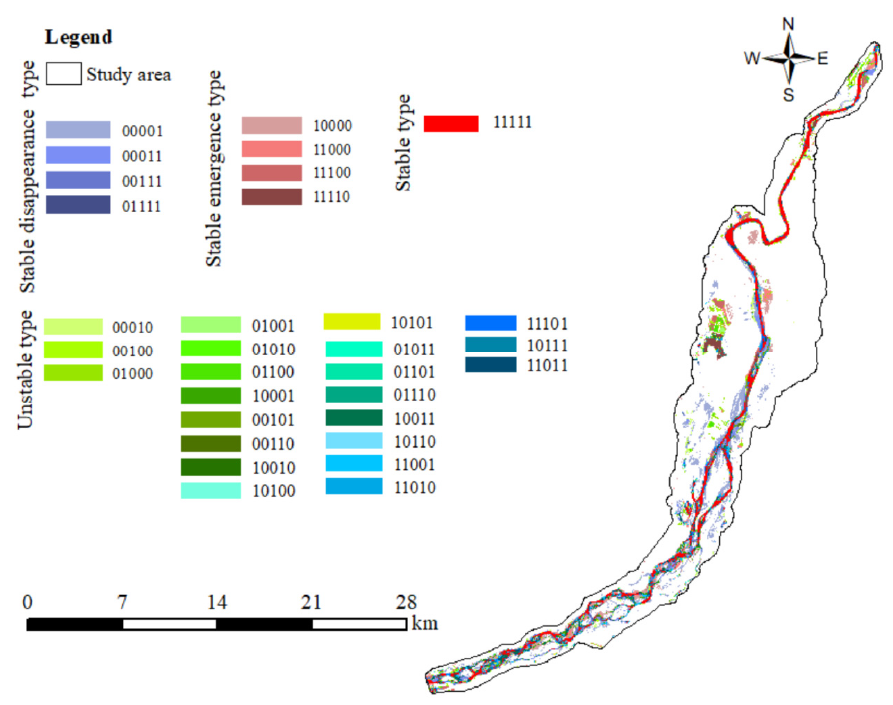
Figure 5. Spatial and temporal map of water distribution.